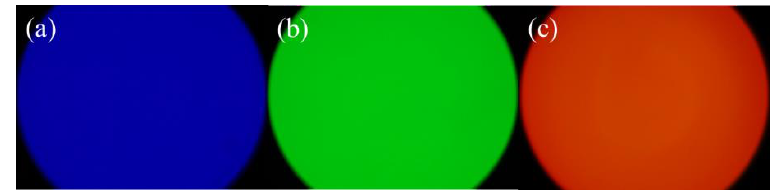
Figure 4. Fluorescence images of CDs/PNIPAM irradiated by different light sources: ( a ) ultraviolet light, ( b ) blue light, and ( c ) green light.